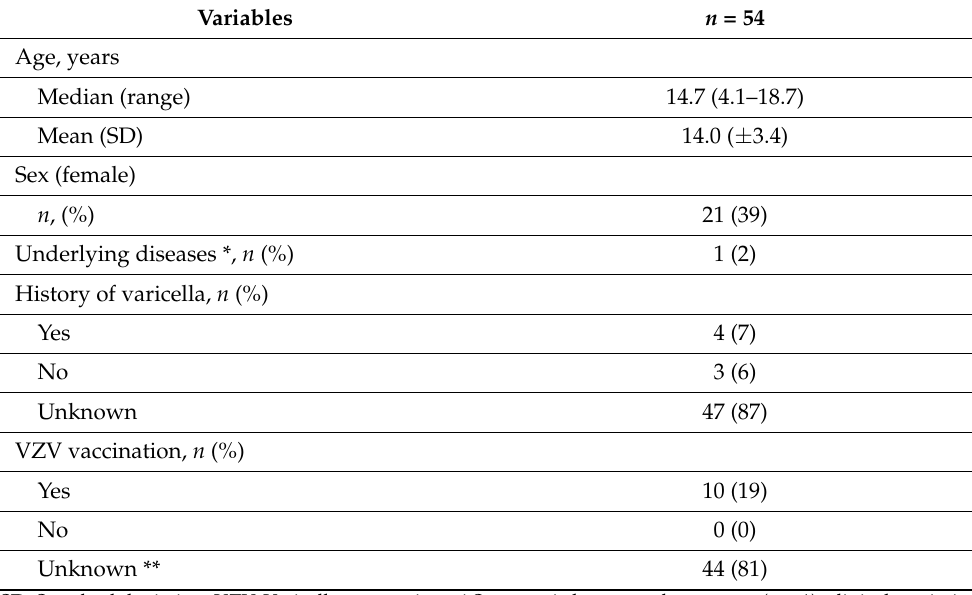
Table 1. Demographic characteristics of patients. Figure 1. Flow chart of the patient-selection process. HZ, Herpes zoster.